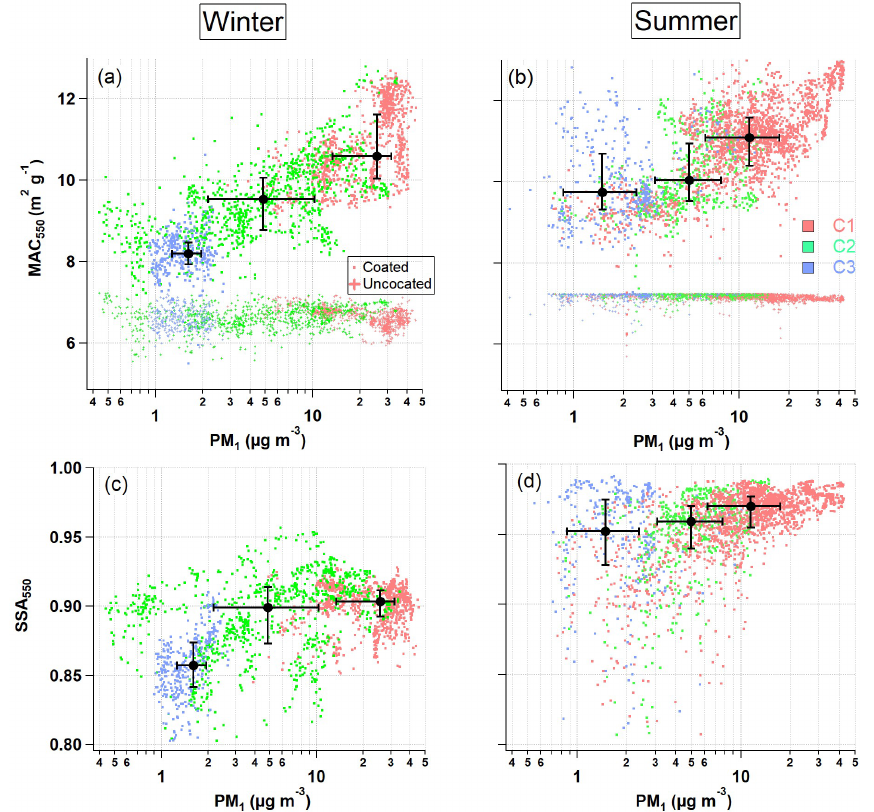
Figure 6. Optical properties of BC for the three PBL types in both seasons. Panels (a) and (b) are the mass absorption cross section at λ = 550nm (MAC 550 ), with dot and plus markers denoting coated and uncoated BC, respectively. Panels (c) and (d) are single-scattering albedo at λ = 550nm (SSA 550 ). In each panel, the solid circles and whiskers denote the median and 25th and 75th percentiles, respectively.